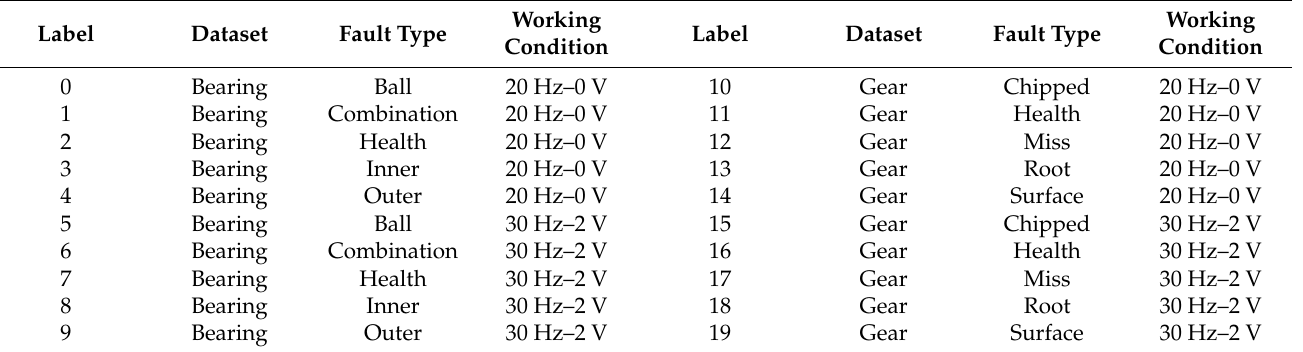
Table 1. The details of SEU.